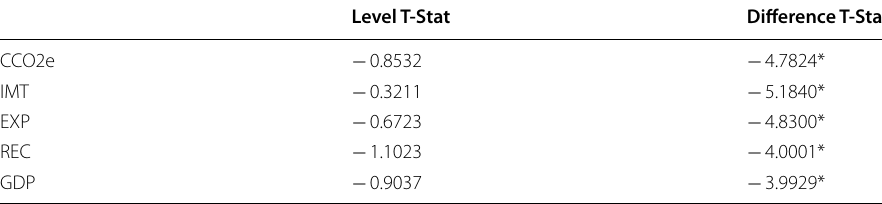
* indicates a level of significance at 1%